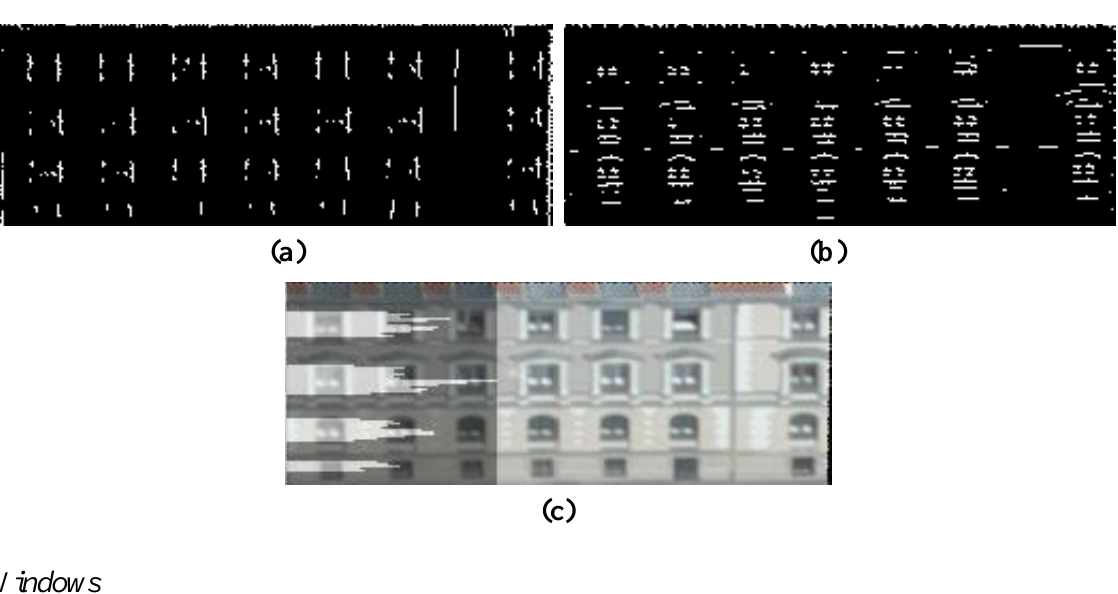
Figure 14. Binary Prewitt edges in ( a ) are vertical, in ( b ) horizontal. The sums of edge values are shown in ( c ) as a count of the number of